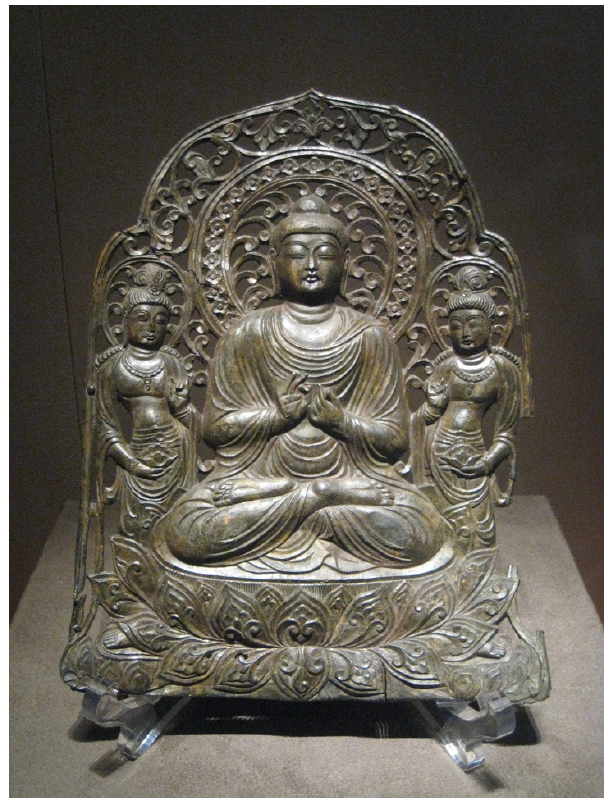
Figure 15. Gilt-bronze Buddha triad plaques . Unified Silla, late seventh century, H. 27 cm, National